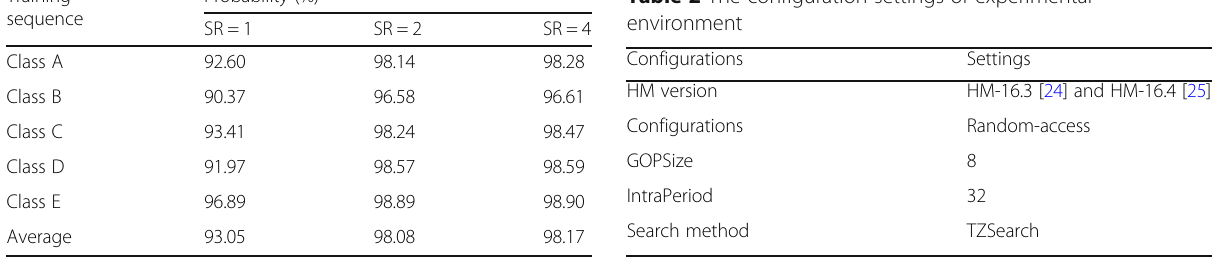
Table 2 The configuration settings of